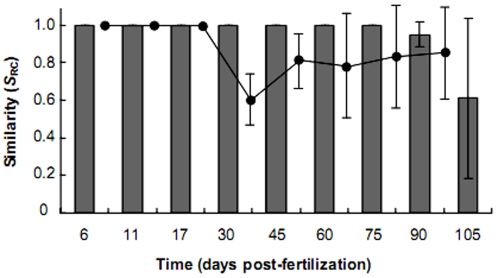
A comparison of changes in similarity values for within and between time points.Bars indicate within time point similarity and circles represent similarity between adjacent time points. Similarity is measured by the Raup and Crick (S
RC) probability-based index of similarity. 0.95>S
RC>0.05 similarity is no greater than expected by chance, S
RC<0.05 significant dissimilarity, S
RC>0.95 significant similarity. Error bars represent the standard deviation of the mean.